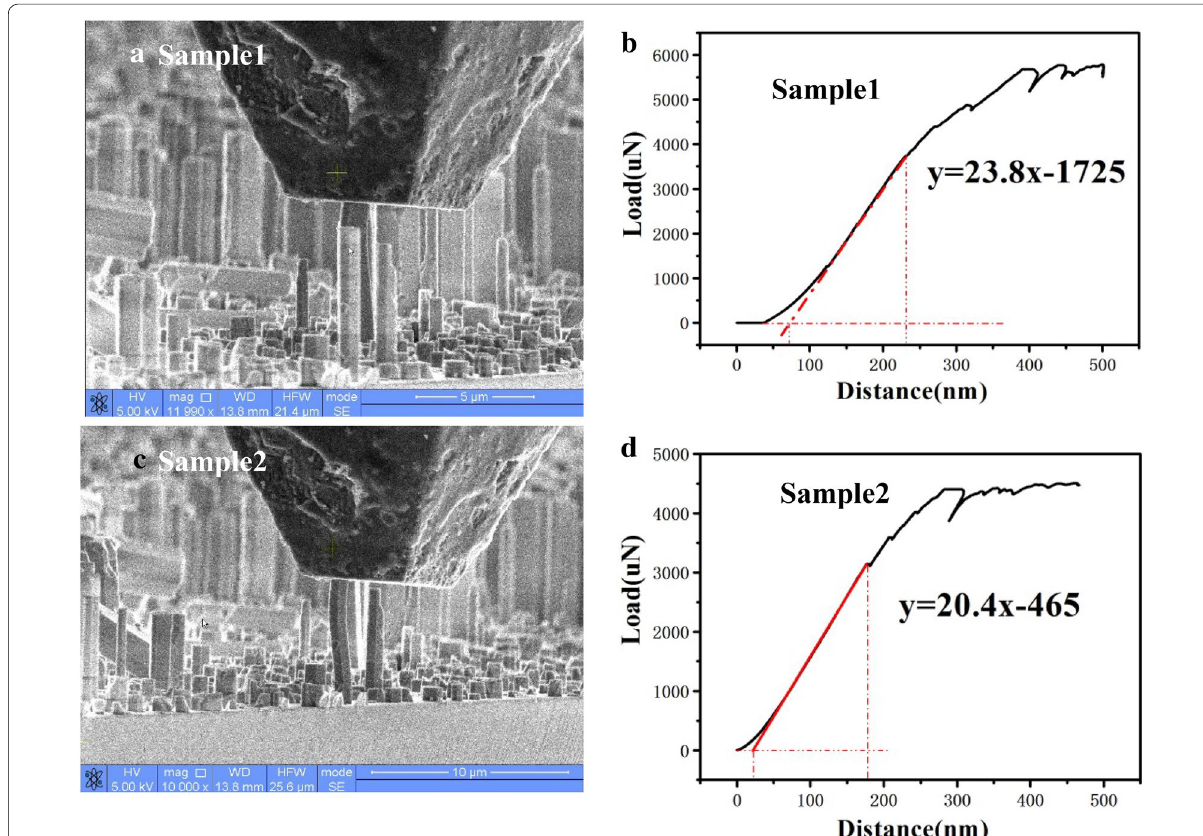
Fig. 2 Compressive stress test by Hysitron sample stage. a , b are the test process and result of sample 1, c , d are the test process and result of sample